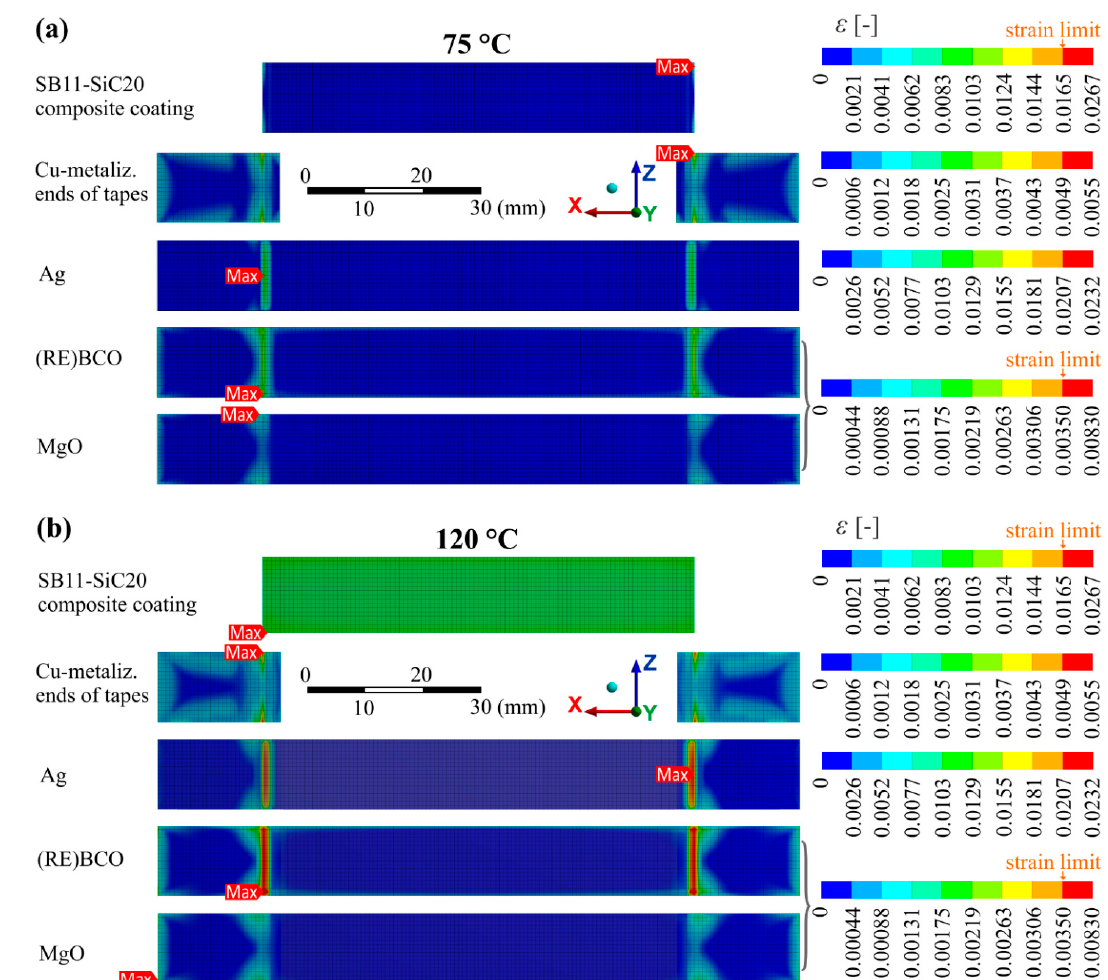
Figure 12. Modeling results of strain distribution in the particular layers (top views) of the HTS tape modified with SB11-SiC20 of 200 µm thickness and quenched at ( a ) 75 °C and ( b ) 120 °C.